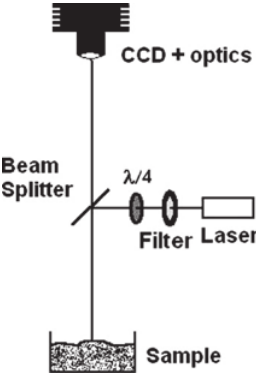
Fig. 1. Setup of laboratory measurements (Kaasalainen et al . 2008a)